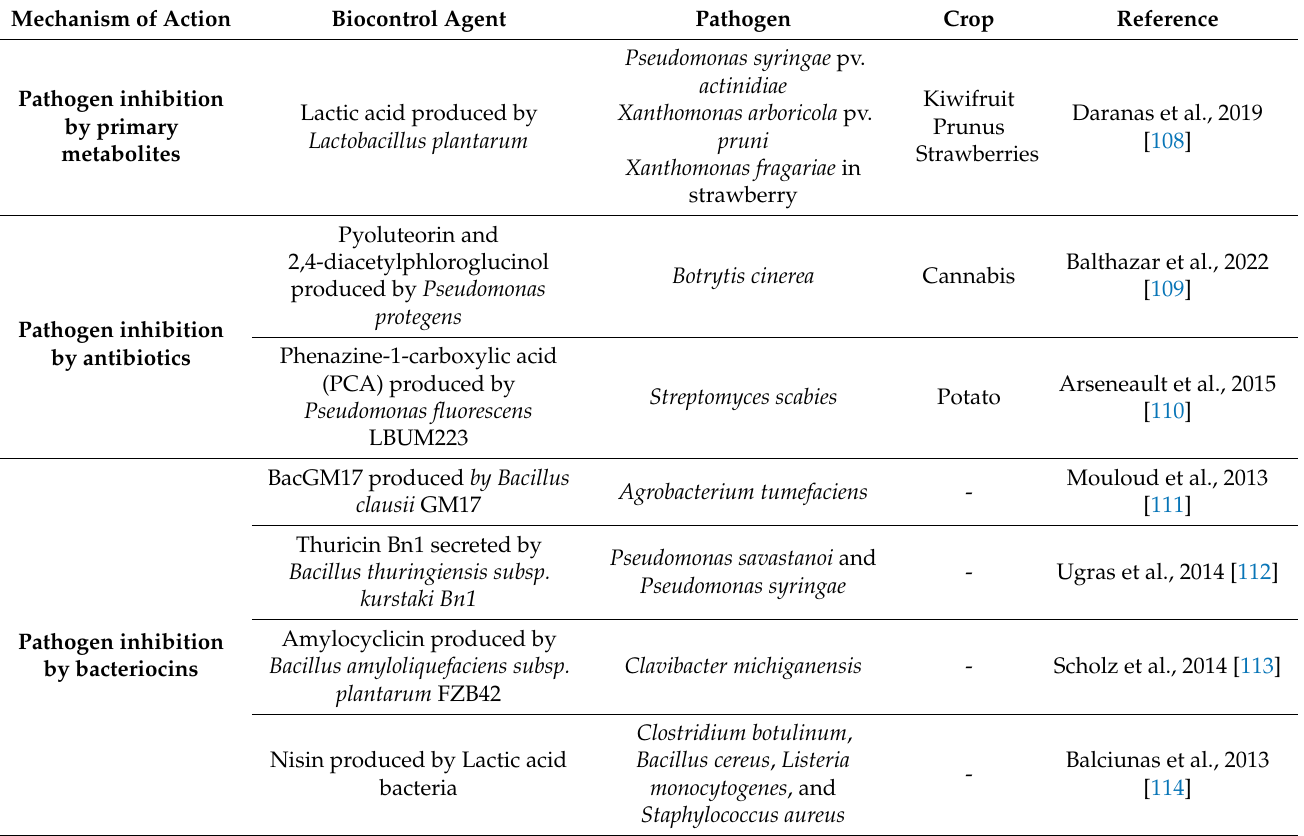
Table 2. Different modes of action of biocontrol agents on different crops that do not involve direct physical contact with the